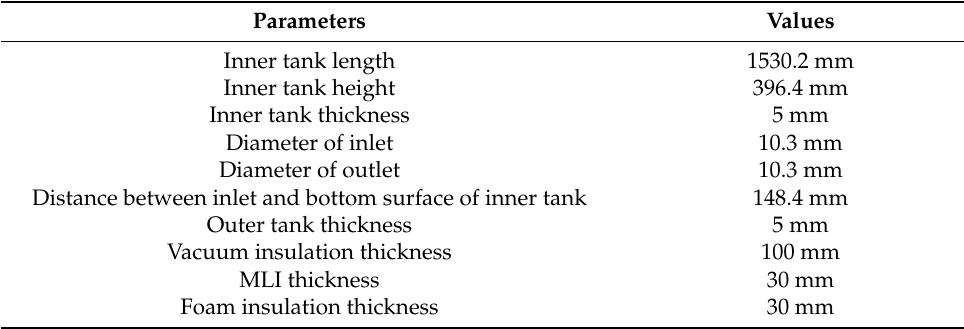
Figure 1. Simulation schematic of the liquid hydrogen storage tank. Table 2. Specifications of the liquid hydrogen tank.